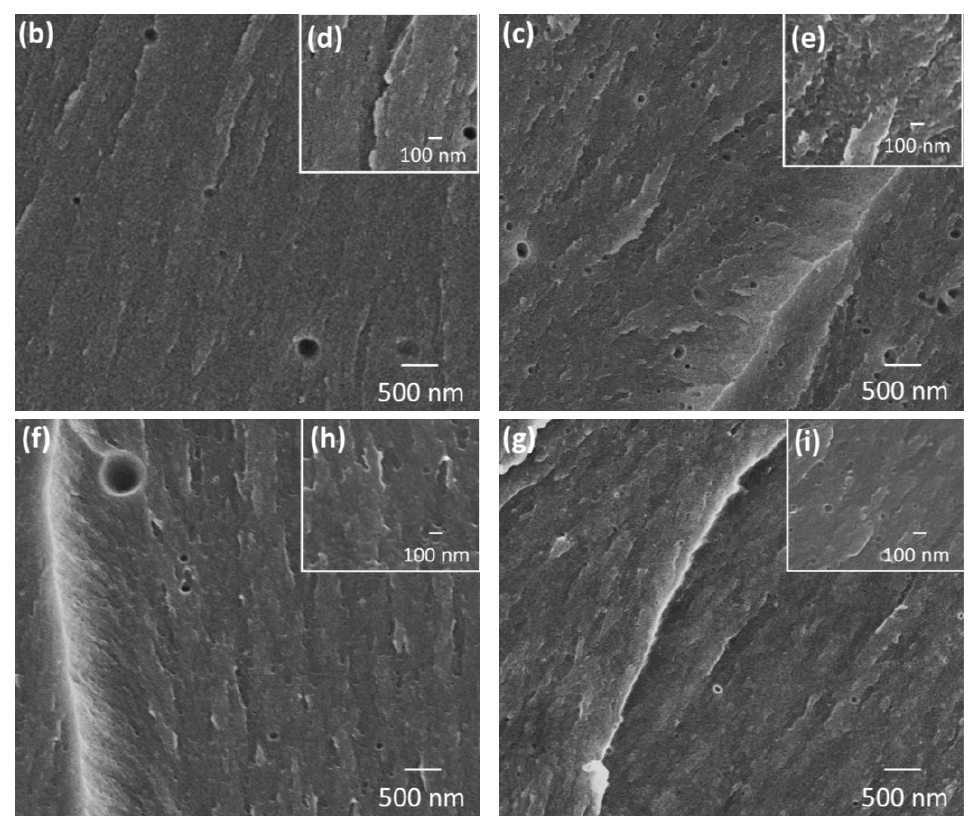
Figure 14. SEM images of the hackle zones of ( a ) the neat epoxy and the nanocomposites with ( b ) 0.3 vol% of 20k20k-SiO ( e ) 0.2 vol% of 40k40k-SiO magnification for 0.2 vol%